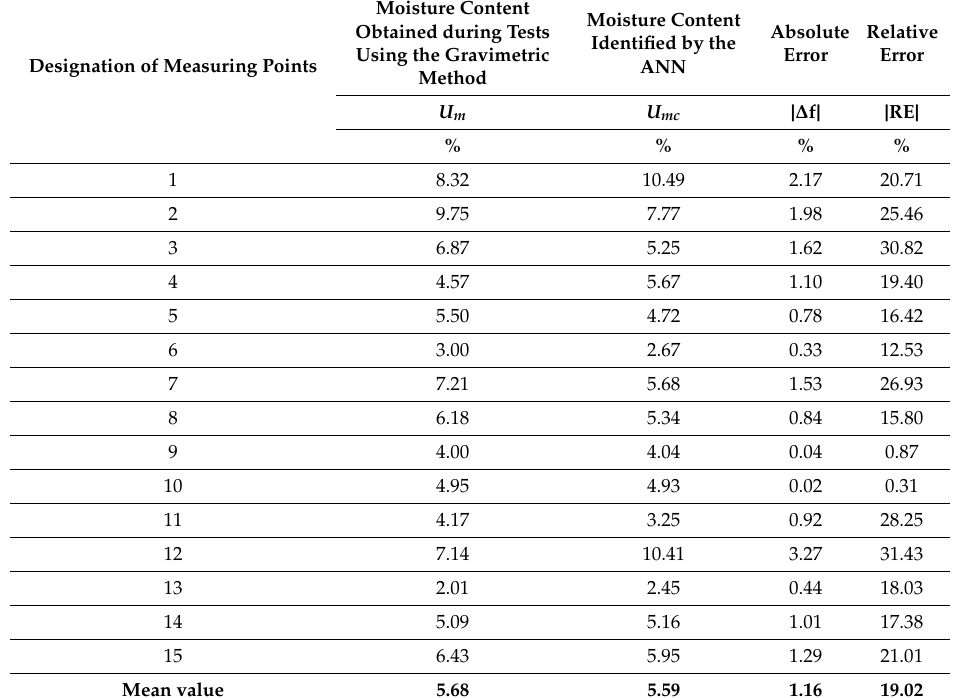
Table 4. Comparative list of selected U m and U mc humidity values determined using the gravimetric method and artificial neural network,